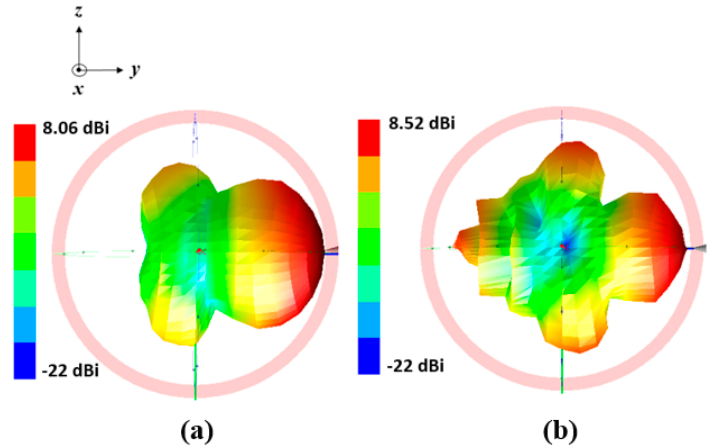
Figure 7. Measured 3-D radiation pattern of the antenna at ( a ) 1.87 GHz and ( b ) at 2.48 GHz.